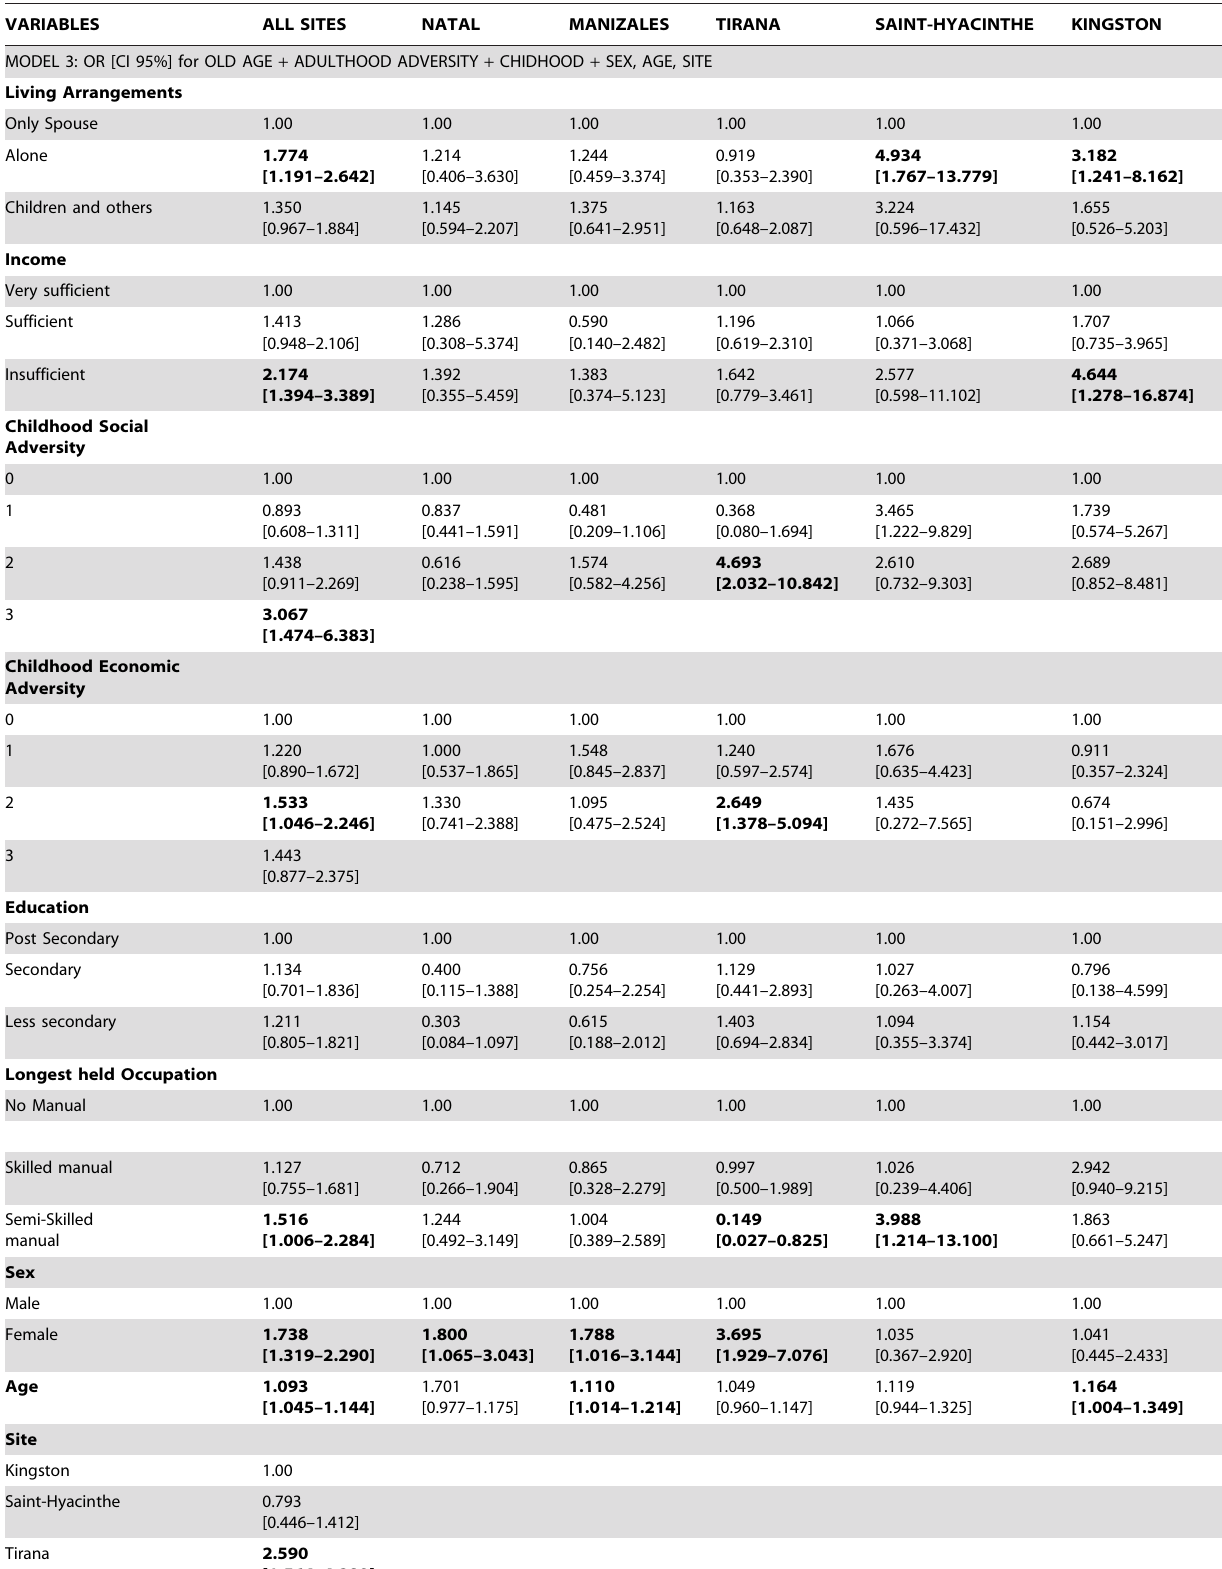
Table 5. Associations between Old Age Adversity and Poor Physical Performance (SPPB , 8).